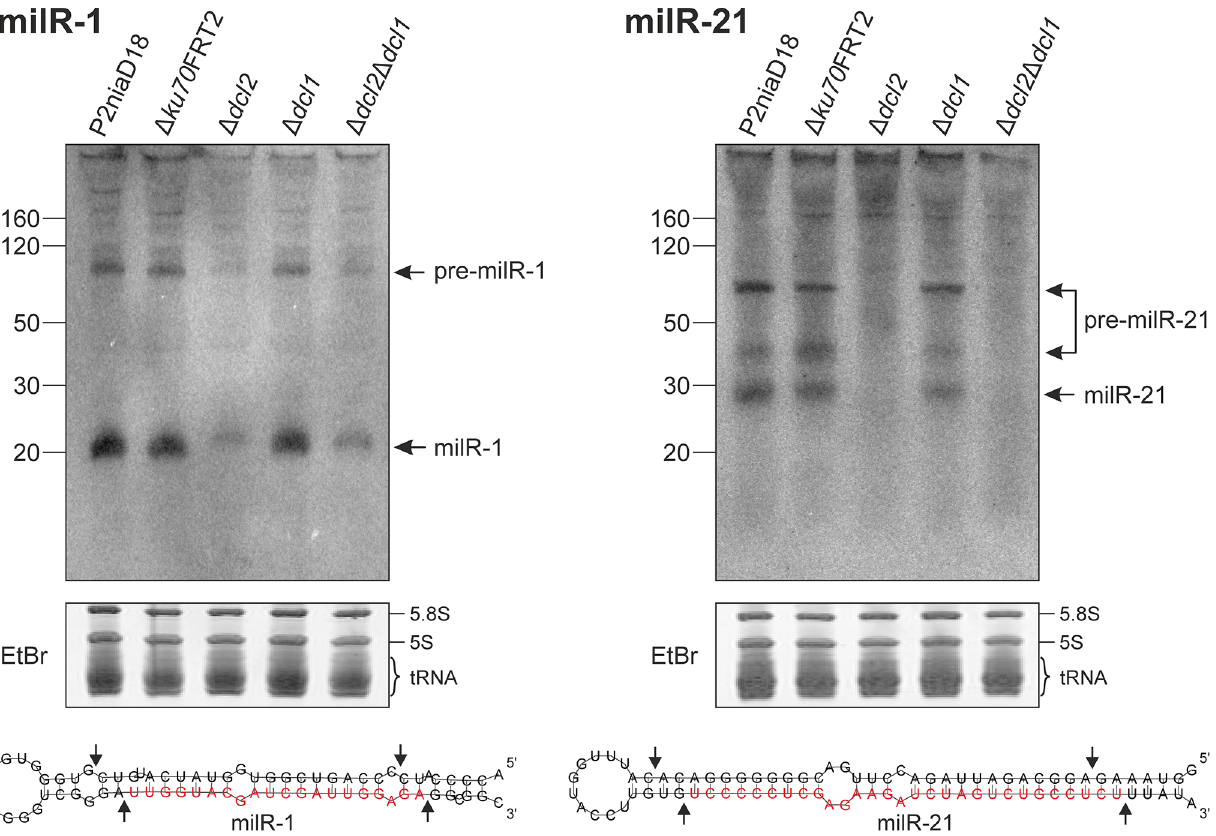
Fig 5. Validation and expression analysis of (A) milR-1 and (B) milR-21. Total RNA from strain P2niaD18, the recipient Δ ku70 FRT2 as well as Dicer single and double mutant strains were used for polyacrylamide gel electrophoresis and northern blot analysis. Mature milRNAs (milRs) and milRNA precursors (pre-milRs) were detected with revers complement 32 P-labled DNA probes. Below, loading controls of the total RNA, stained with ethidium bromide (EtBr), and the predicted secondary structures of milRNA precursors are given. On the secondary structures, milRNA sequences are highlighted in red and arrows indicate the expected Dicer cleavage sites.